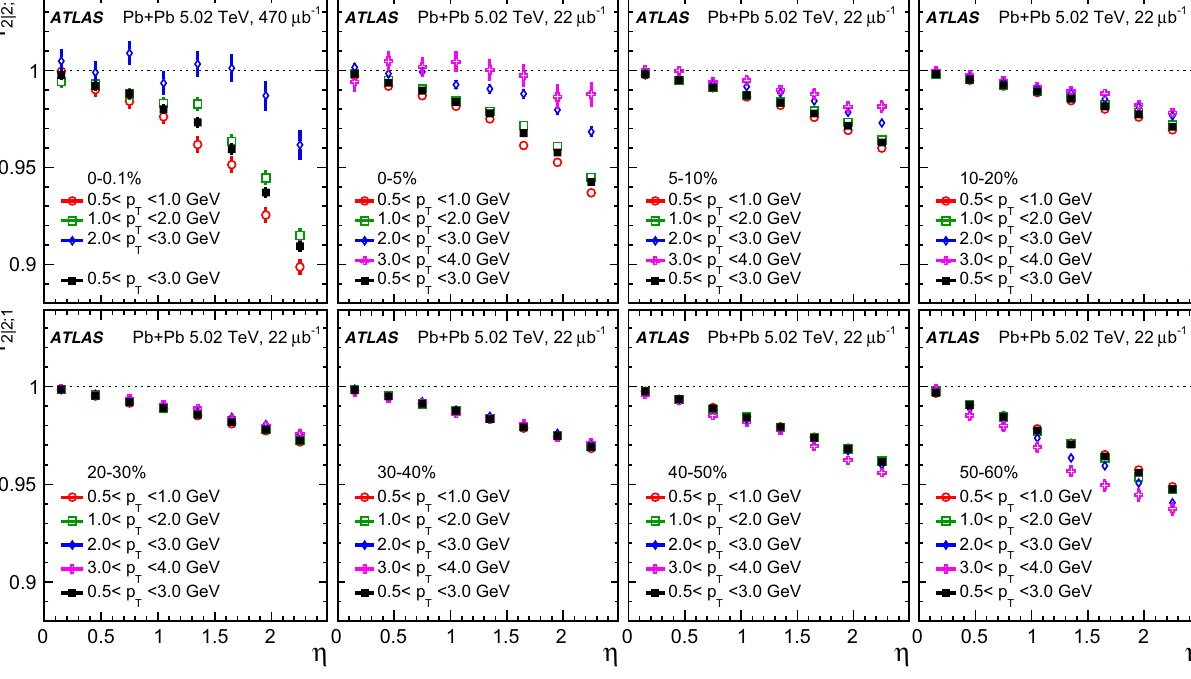
Fig. 4 The r 2 | 2 ; 1 (η) measured in several p T ranges. Each panel shows the results for one centrality range. The error bars are statistical